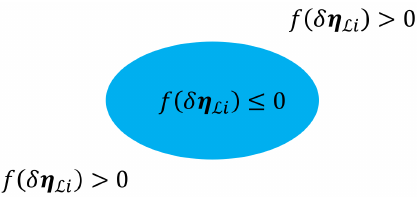
Figure 3. Example of objective